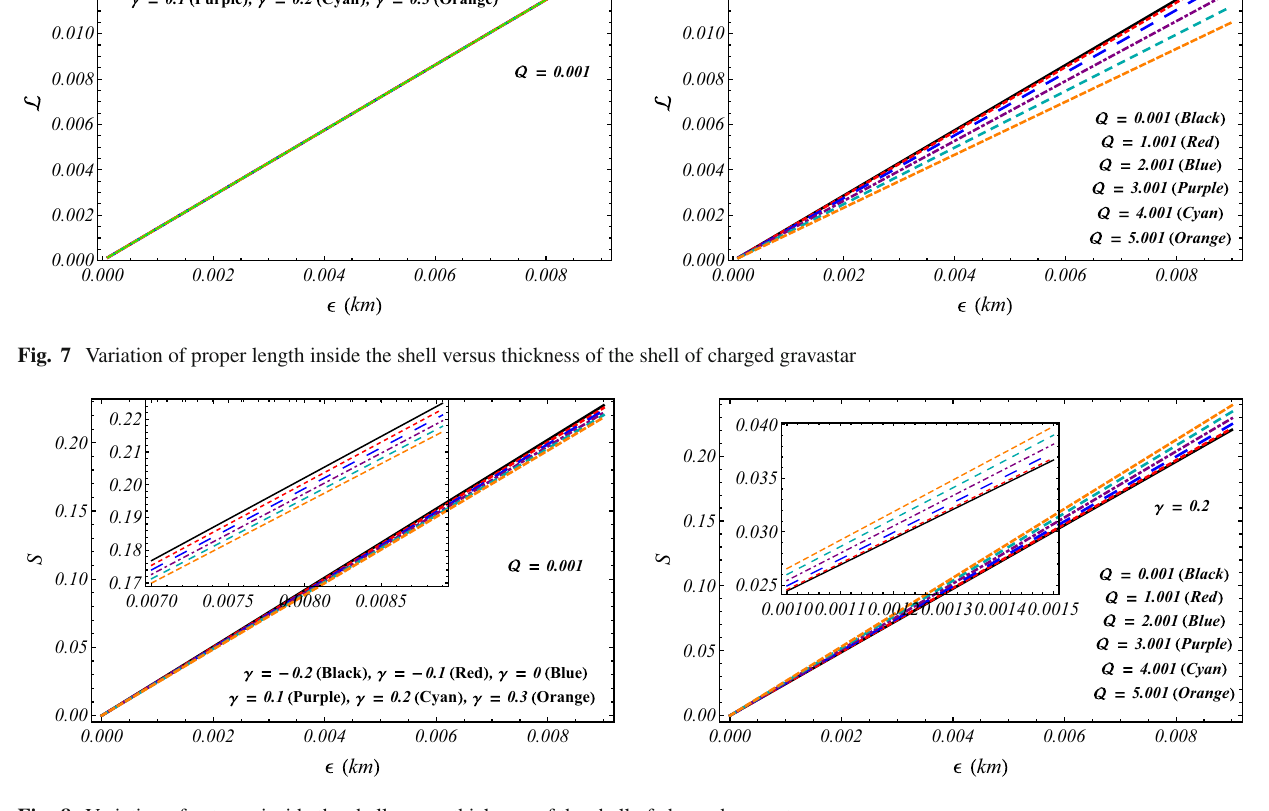
Fig. 8 Variation of entropy inside the shell versus thickness of the shell of charged gravastar